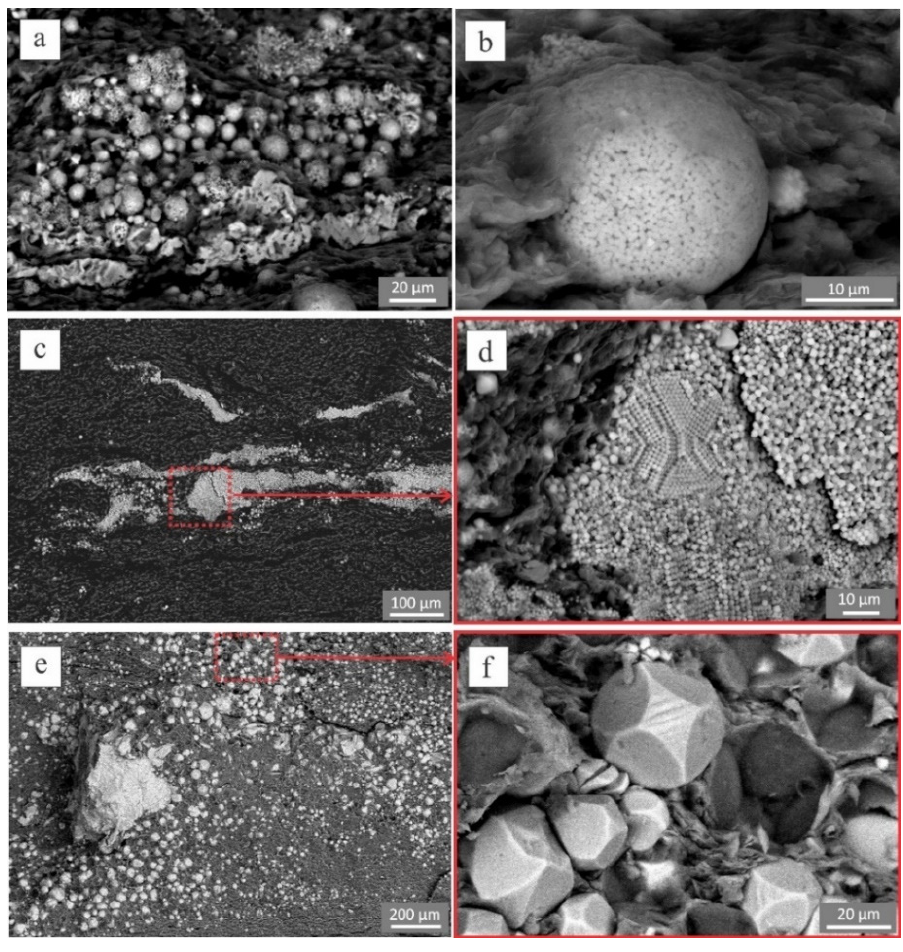
Figure 3. Morphologies of pyrite in the studied sediments (SEM images in secondary electrons mode): ( a ) Small framboids; ( b ) Large framboids; ( c,d ) Small crystals; and ( e,f ) Large euhedral crystals. Scale bars shown on each